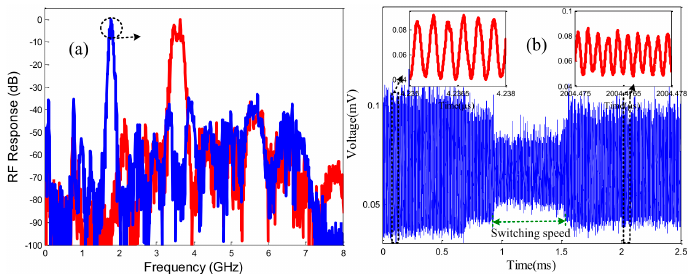
Figure 10. ( a ) Structure diagram of the optical spectral shaper. ( b ) The overall layout of the device. ( c ) Cross-section view of the waveguide (with the courtesy of Dr M. Li).